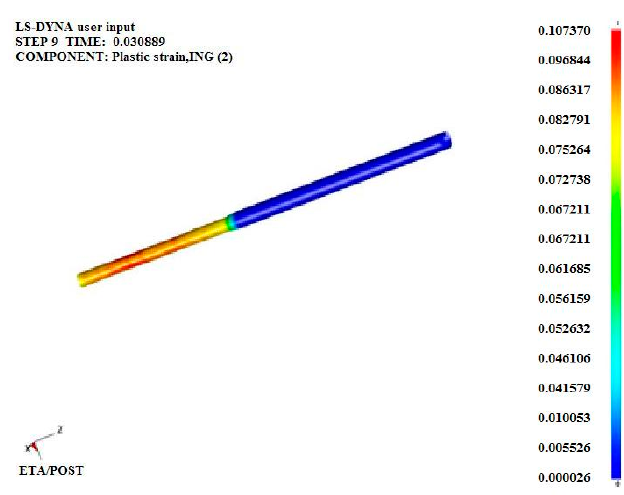
Figure 17. Drawing force at the eleventh draw F = 0.090 kN